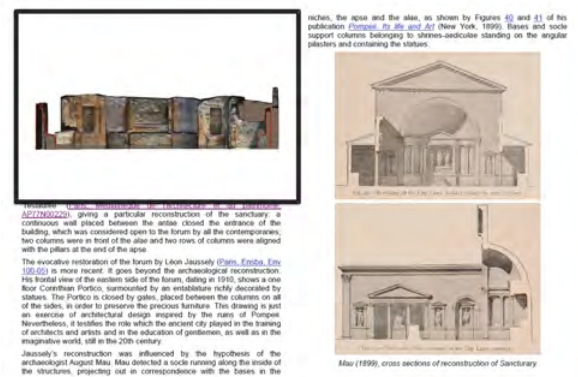
Figure 5. Screenshot of 3D PDF with floating